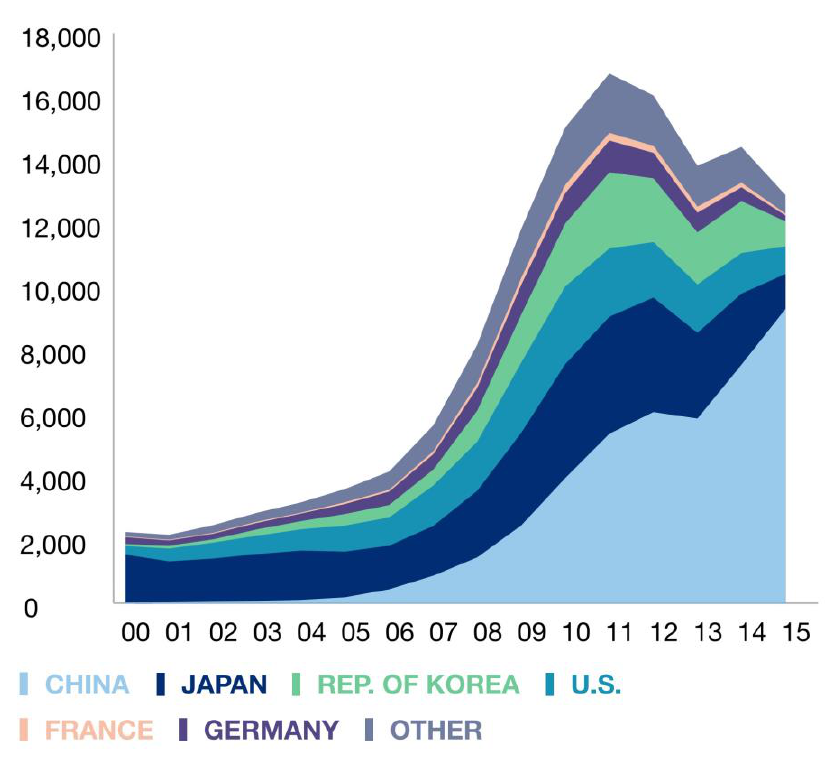
Figure 3. First filings of PV-related patents by origin. Note: Horizontal axis—year; vertical axis— first filings of PV-related patents (number). (Reproduced with permission from [World Intellectual Property Report 2017], World Intellectual Property Organization, 2017[4]).